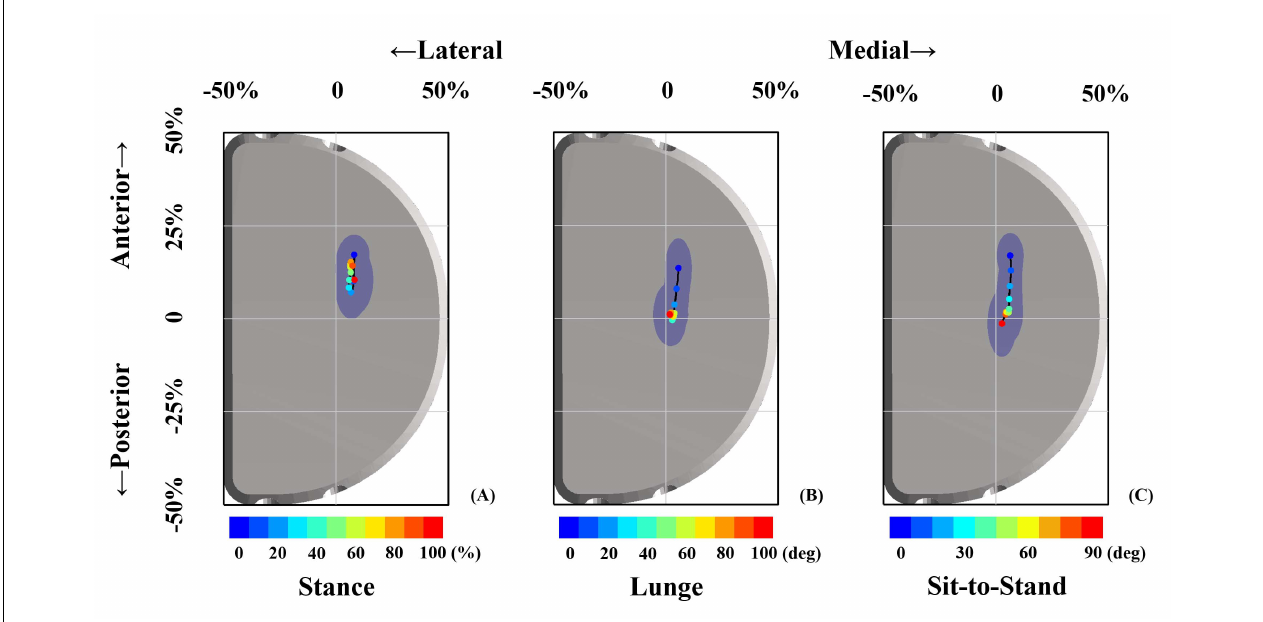
FIGURE 3 | Articular contact excursions during the stance phase (A) , single-leg lunge (B) , and sit-to-stand motion (C) are shown. The scatters with different colors represented contact positions in the stance phase period (A) and knee flexion angle (B,C) . The blue dashed area indicated one standard deviation of contact position in anterior–posterior and medial–lateral